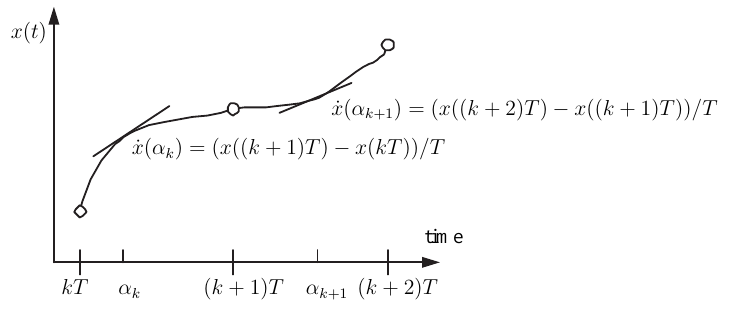
Figure 5 . Mean-value-theorem and α